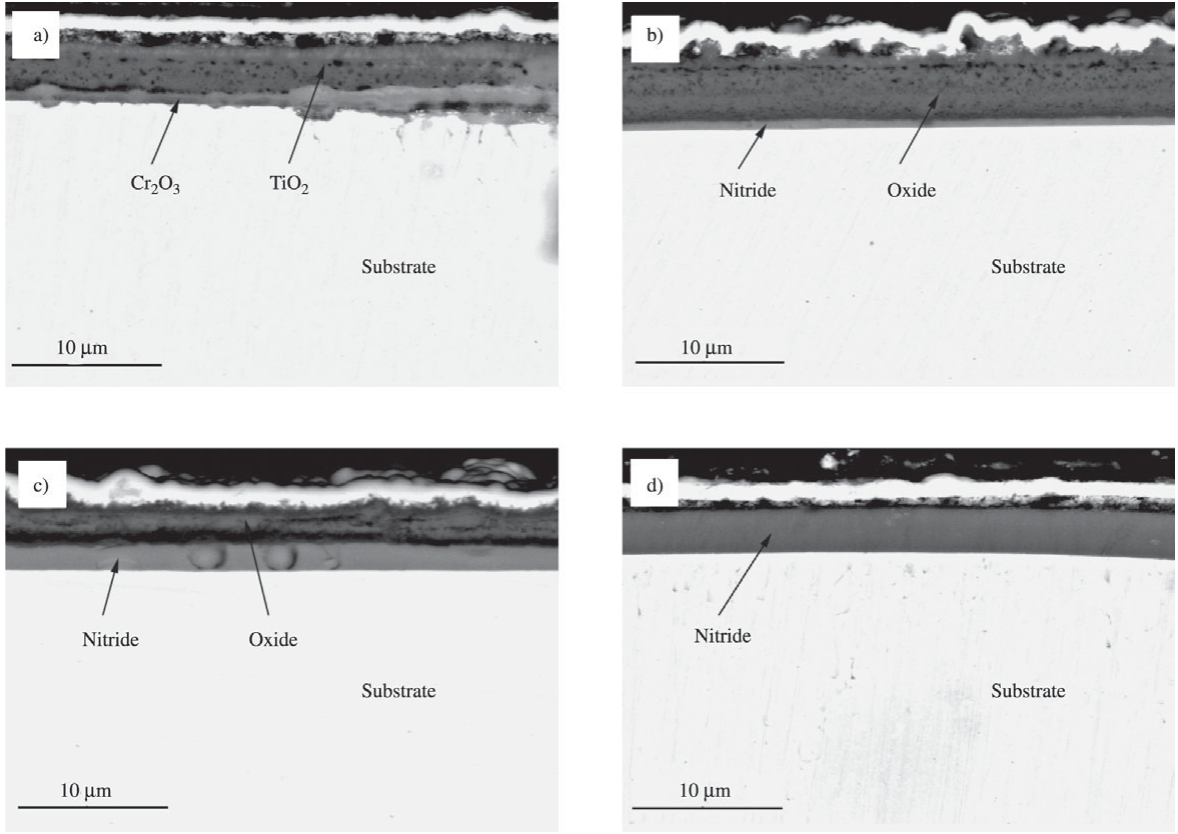
Figure 5. Cross section of coatings (Ti